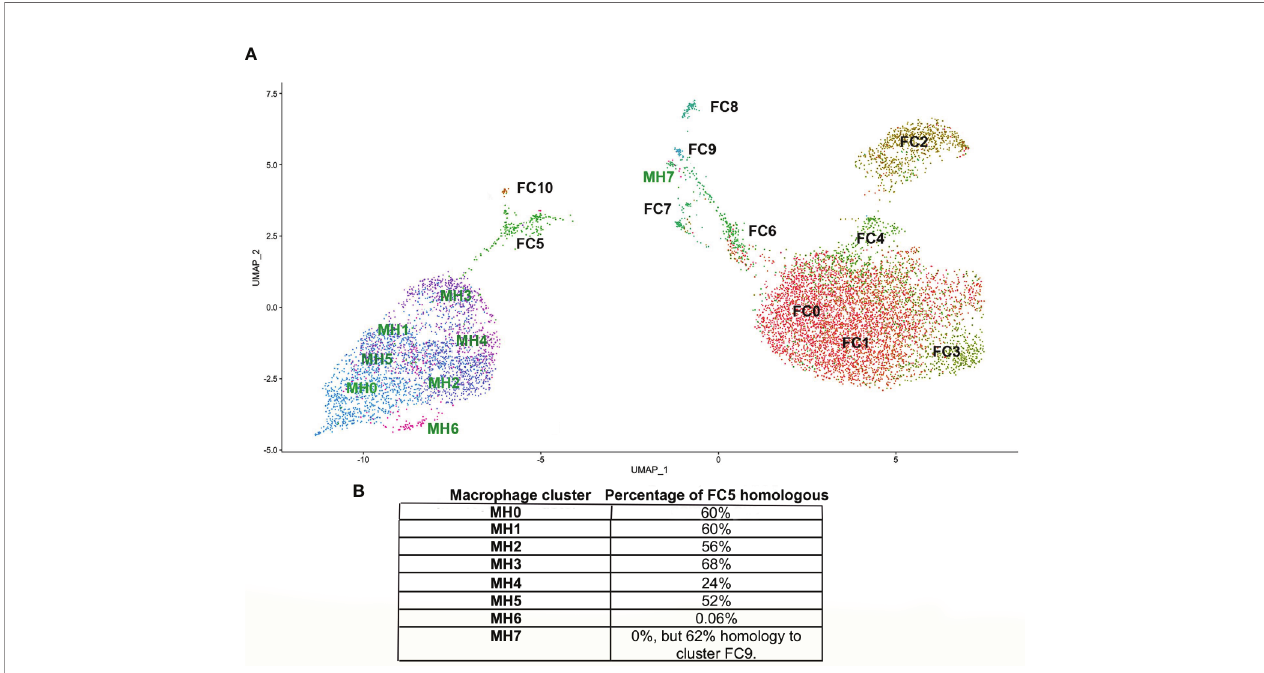
FIGURE 8 | (A) Co-embedding of the Seurat from HO with that from fracture callus. In order to more accurately assess common features between the MH and FC clusters they were co-embedded by fi rst processing the gene activity matrix in order to fi nd anchors between cells in the MH and FC datasets. These anchors were then used to transfer the data by the standard work fl ow in Seurat to plot the co-embedded dataset. (B) The percentage of the top 50 transcripts of each MH cluster present in FC5 are indicated. Although cluster MH7 has no transcripts in FC5, it has 62% of its transcripts present in